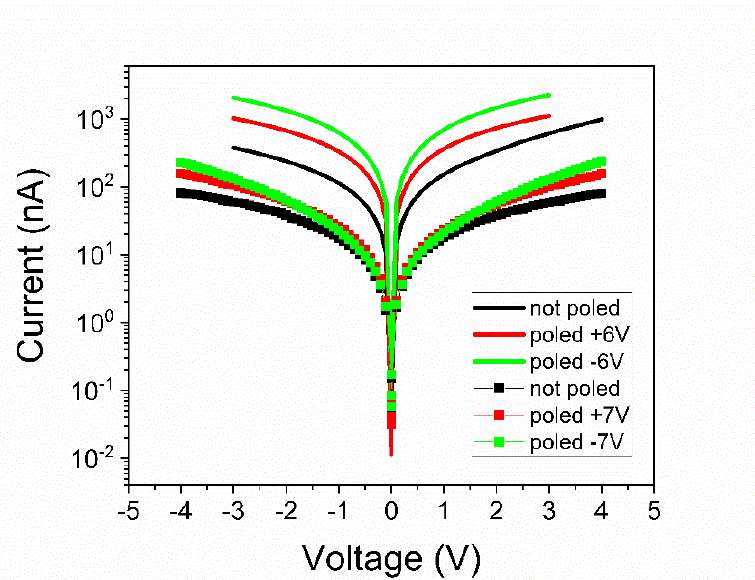
Figure 7. I–V characteristics obtained for PZT films grown from commercial target (lines) and from pure target (markers).